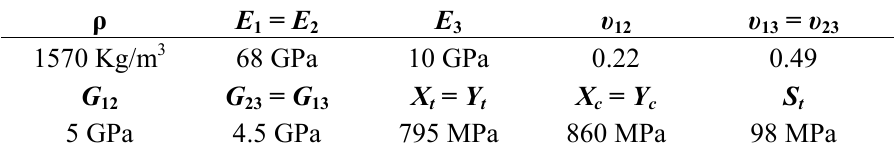
Table 1. Characteristics and mechanical properties of the composite.